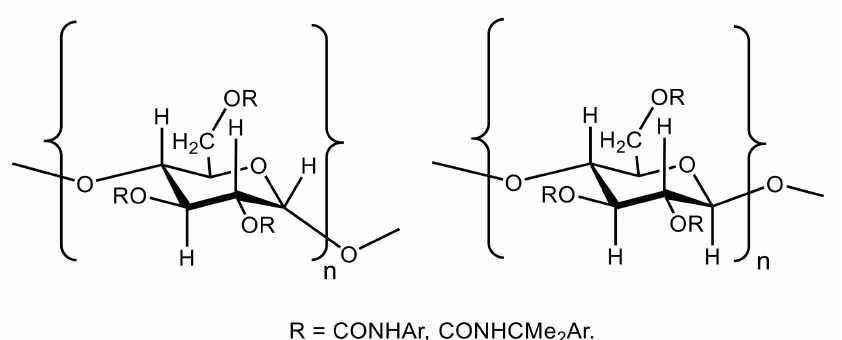
Figure 46. Chemical structures of amylose tris(3,5-dimethylphenylcarbamate) (ADMPC), amy- lose tris[(S)-R-methylbenzylcarbamate] (ASMBC), and cellulose tris(3,5-dimethylphenylcarbamate) (CDMPC). Amylose has the α -D-(1 → 4) linkages and cellulose has the β -D-(1 → 4) linkages. Lefort and coauthors [158] demonstrated that chemical shift surfaces contained infor- mation on distributions of various conformations of disaccharides in glassy solid state. The authors found with paying particular attention to the glycosidic linkage atoms in three classical disaccharides, trehalose ( 91 ), sucrose ( 92 ), and lactose ( 93 ) (see Figure 47), that chemical shift surfaces of glassy disaccharides were almost independent of the method chosen for optimizing their molecular conformations.